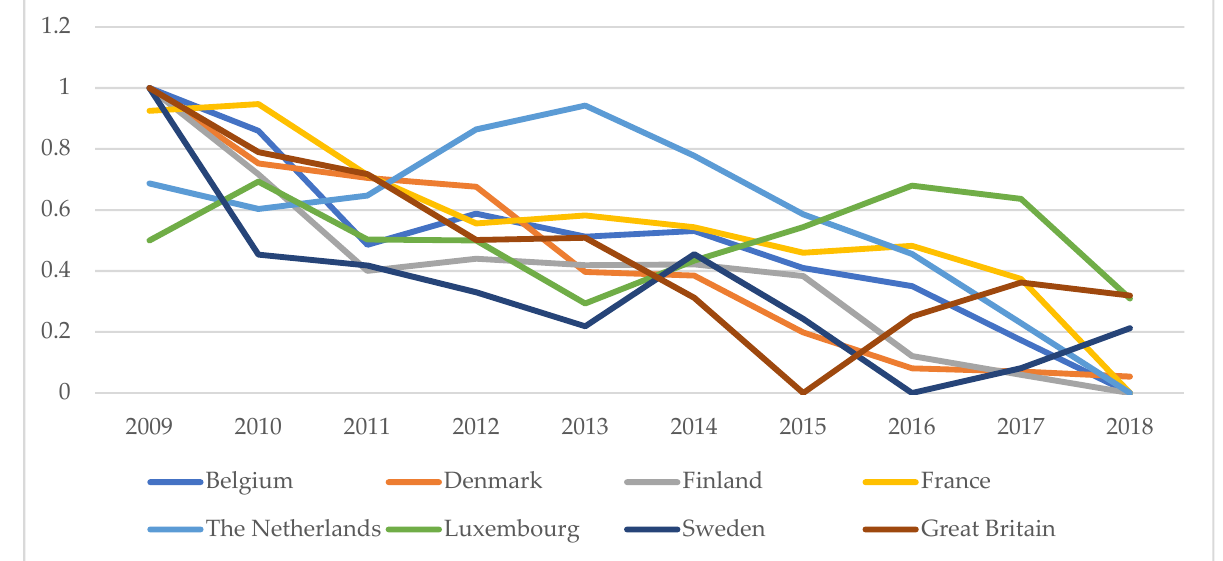
Figure A3. Trends in environmental tax in 2009–2018, TOPSIS value index. Source: Reproduced from [16], Eurostat: 2009–2018.